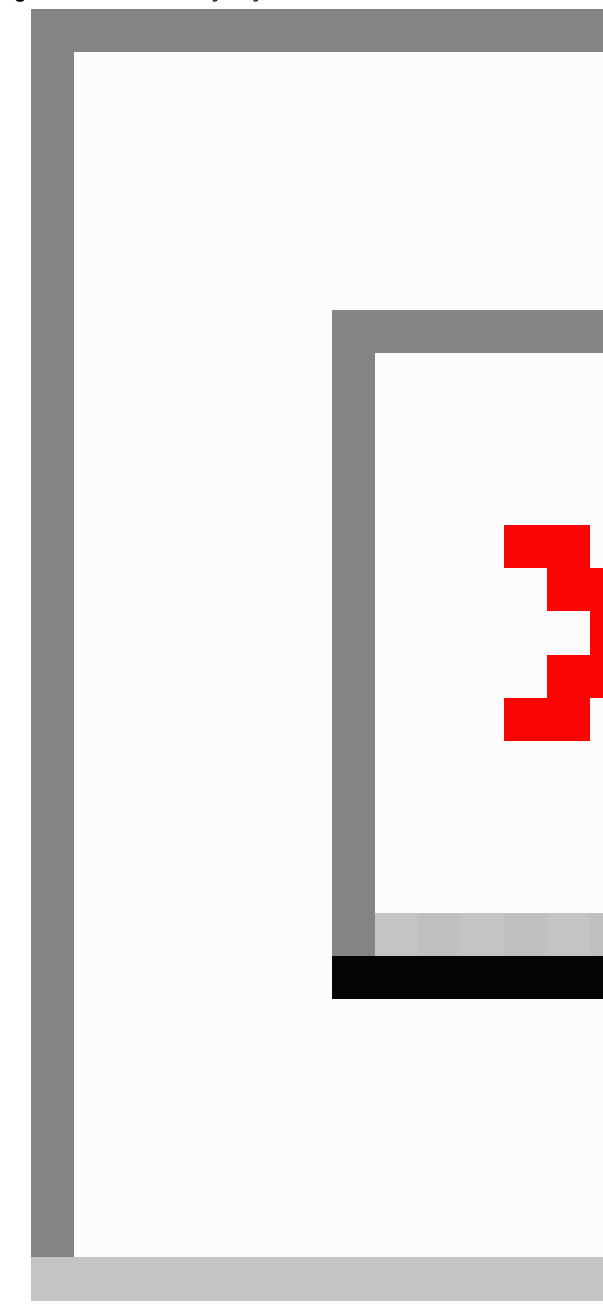
Figure 1. eHealth literacy Lily Model